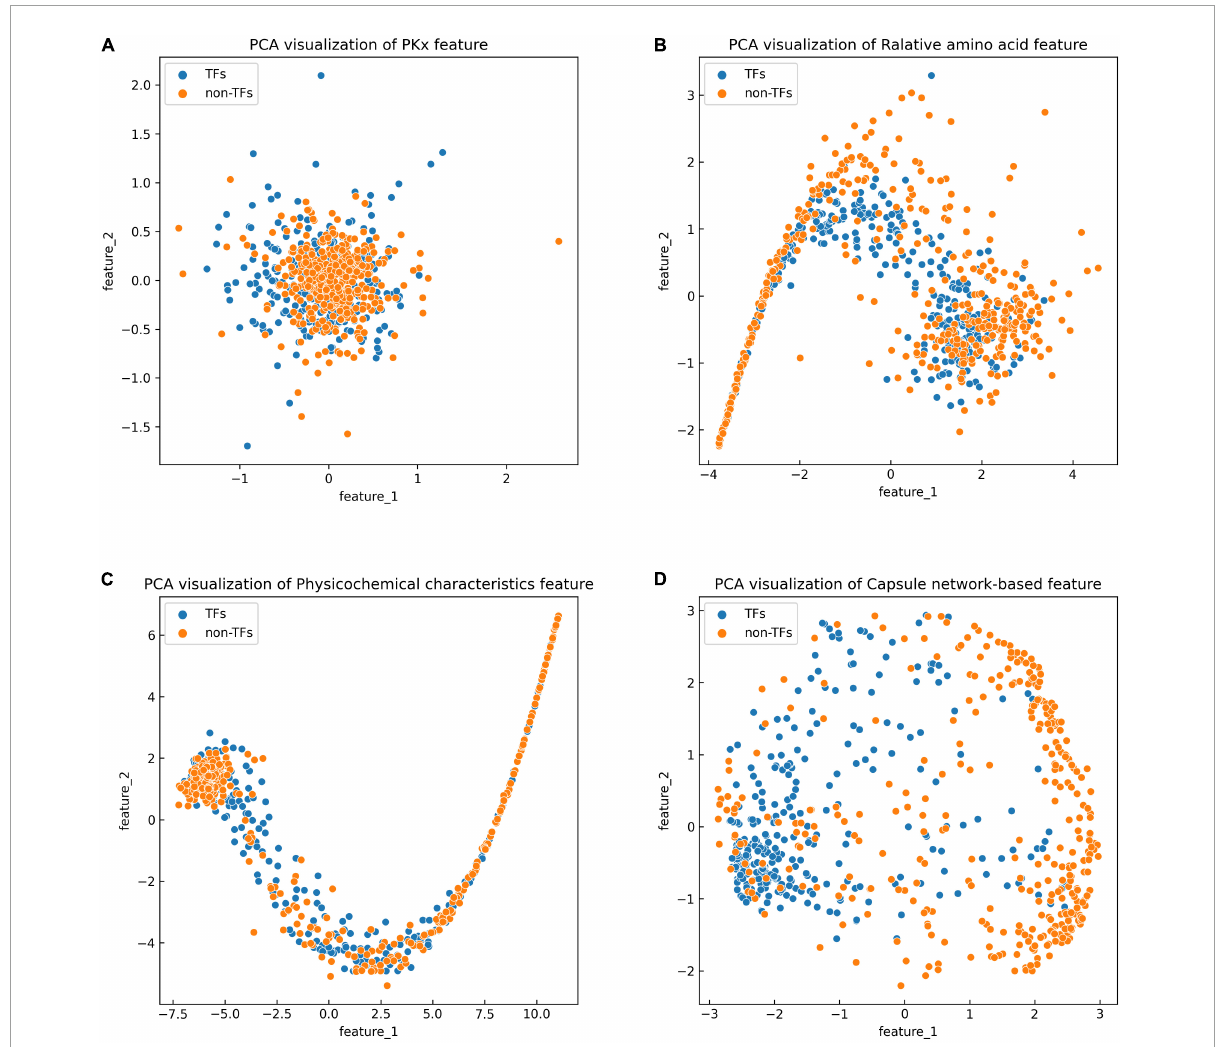
FIGURE4 Principal component analysis (PCA) visualization about the different features: (A) PKx, (B) relative amino acid propensity, (C) physicochemical characteristics, and (D) capsule network-based features. As seen in this image, orange represents non-TFs and blue represents TFs.